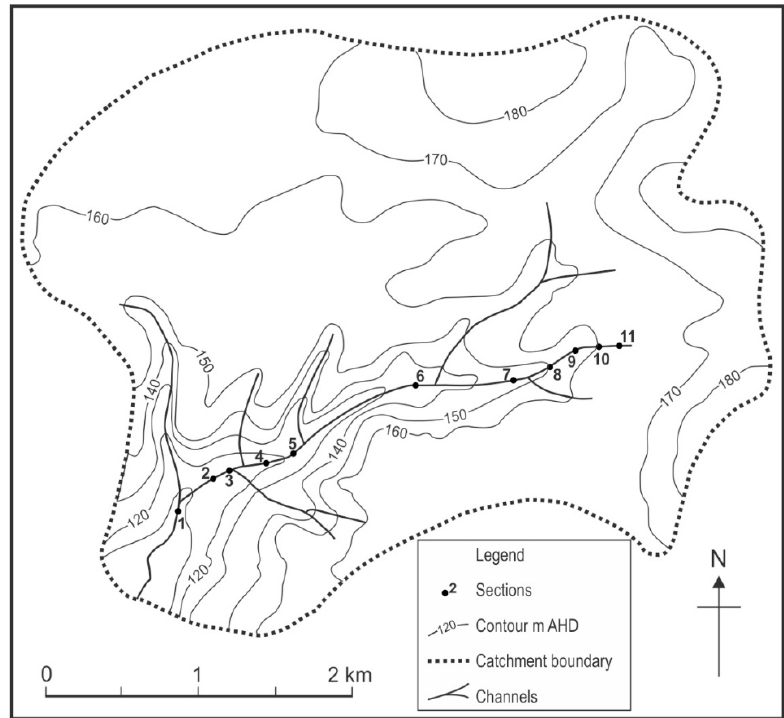
Figure 3. Takalarup Creek catchment and section locations. Numbers on the figure are cross sections and sampling sites.